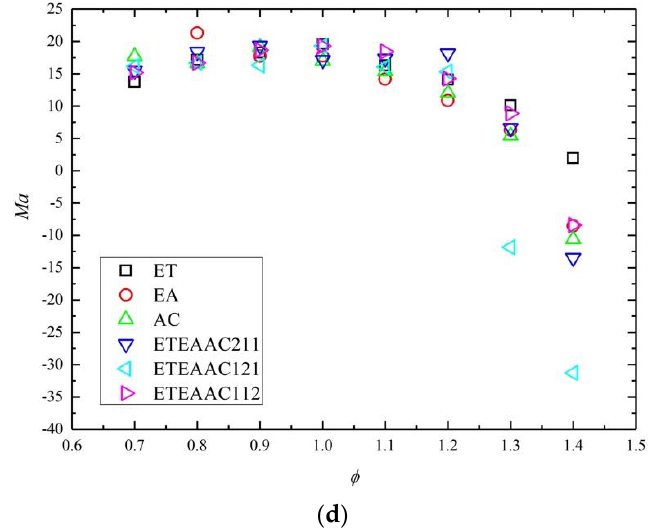
Figure 5. Markstein length and Markstein number of the ternary fuels at T 0 = 358 K, P 0 = 1 bar, and ϕ = 0.7 – 1.4. ( a ) The Markstein length of ET/EA/AC/ETEAAC122/ETEAAC212/ETEAAC221, ( b ) The Markstein length of ET/EA/AC/ETEAAC211/ETEAAC121/ETEAAC112, ( c ) The Markstein number of ET/EA/AC/ETEAAC122/ETEAAC212/ETEAAC221, ( d ) The Markstein number of ET/EA/AC/ETEAAC211/ETEAAC121/ETEAAC112.